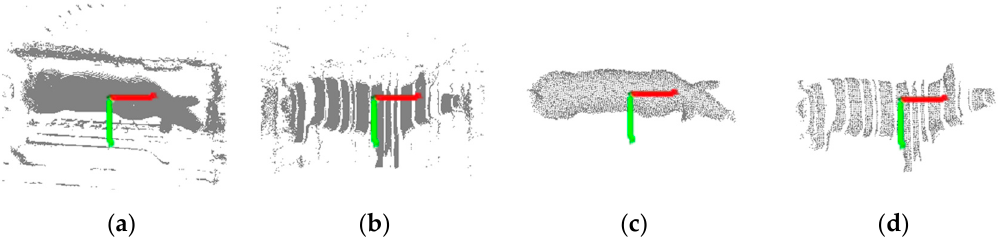
Figure 3. Pig point cloud preprocessing. In these images, the red axis is the x -axis, and the green axis is the y -axis. ( a ) and ( b ) Top- and side-view pig point clouds extracted from depth images after background difference processing; ( c ) and ( d ) Top- and side-view pig point clouds obtained after filtering and segmentation.